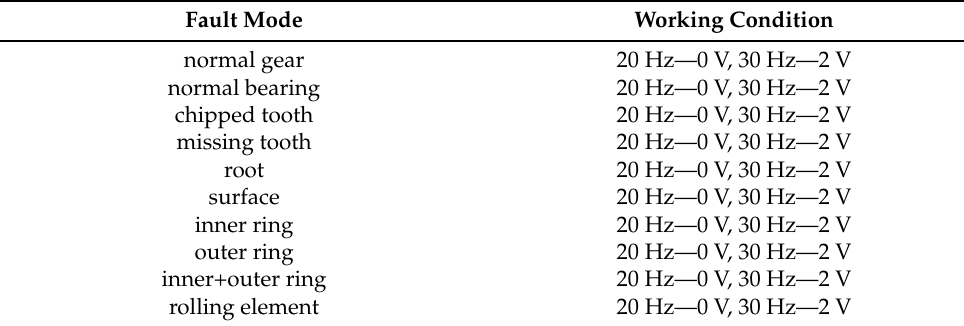
Table 6. Detailed description of the gear datasets.